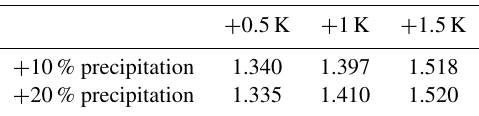
Figure 5. Lake depths on the Larsen C Ice Shelf as calculated from Landsat data from 6 January 2016 using the method of Pope et al. (2016). The horizontal axis gives lake depths in millimetres and the vertical axis gives the number of 30m pixels for each depth. Table 1. The average lake depths (m) for a variety of possible future climate scenarios for Larsen C. The reference case simulation value with no increase in either temperature or precipitation was